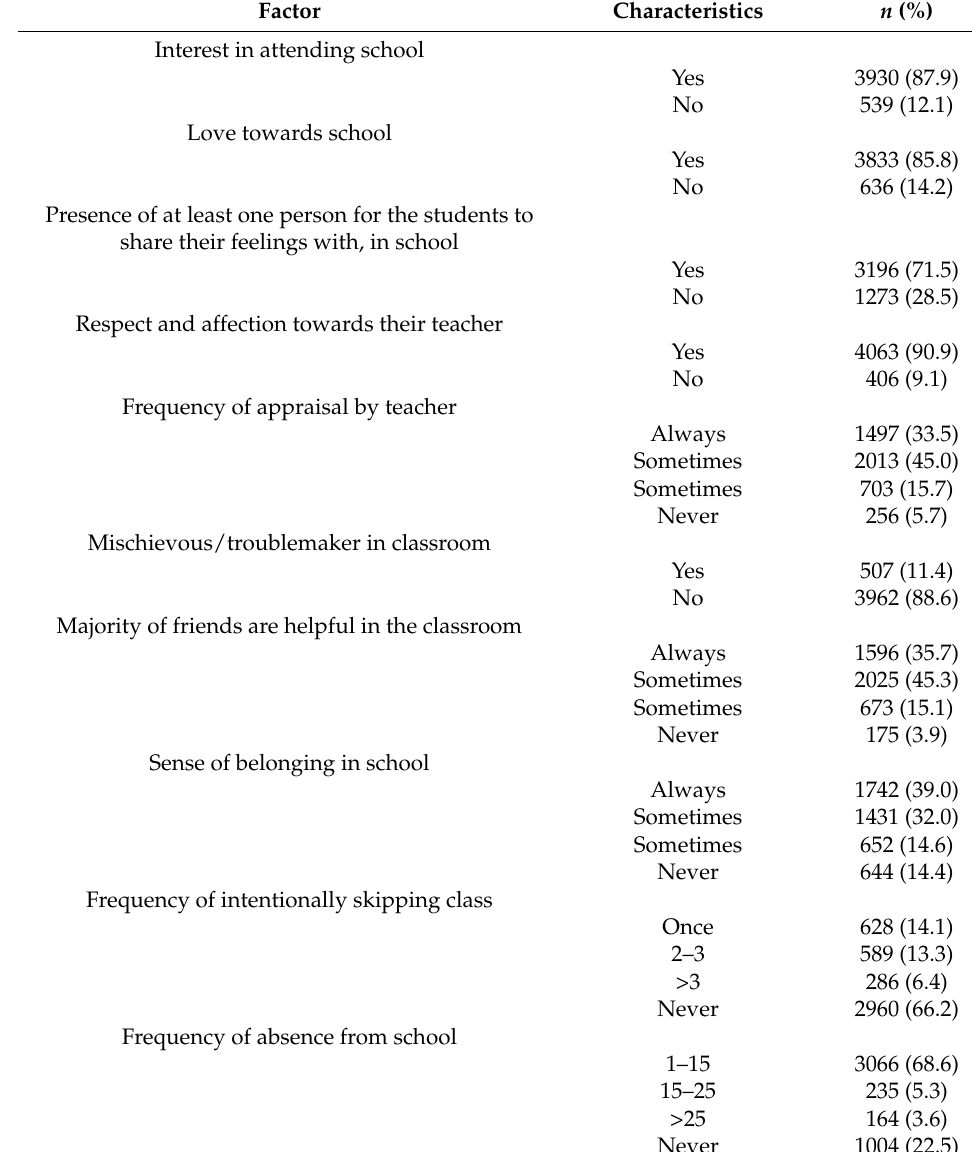
Table 4. Distribution of school factors ( n =